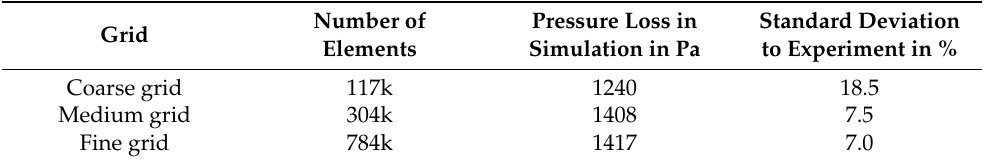
Table 3. Comparison pressure drop for three grids between simulation and experiment at a classifier speed of 900 rpm .